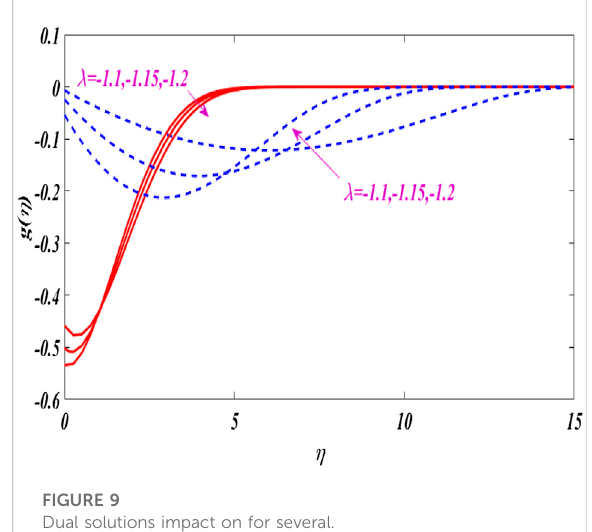
Dual solutions impact on for several.